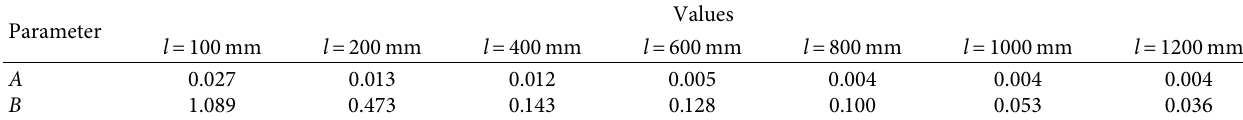
Table 6: Values of a and b under different rock